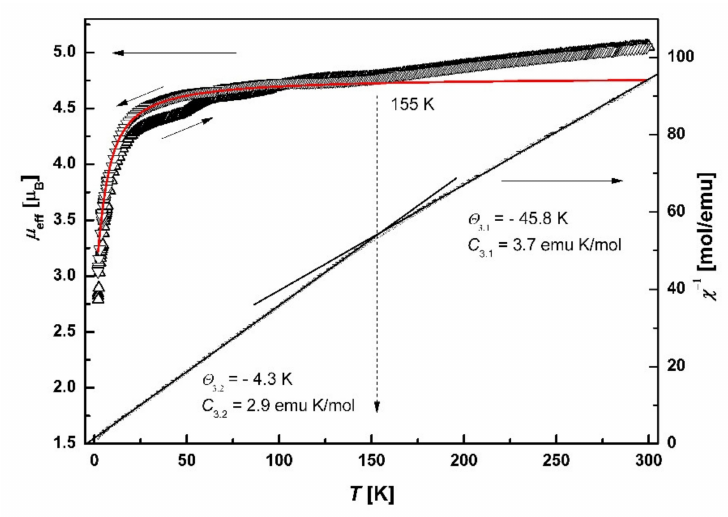
Figure 12. The temperature dependences of the effective magnetic moment, µ eff , and the inverse magnetic susceptibility, χ –1 , for 3 . Solid lines correspond to the Curie–Weiss fit with Θ 3.1 = − 45.8 K (180 < T < 300 K) and Θ 3.2 = − 4.3 K (7 < T < 140 K). The solid red line represents the best fit within the Bonner–Fisher model for HS chains ( J 3 HS = − 1.0 K), including PM